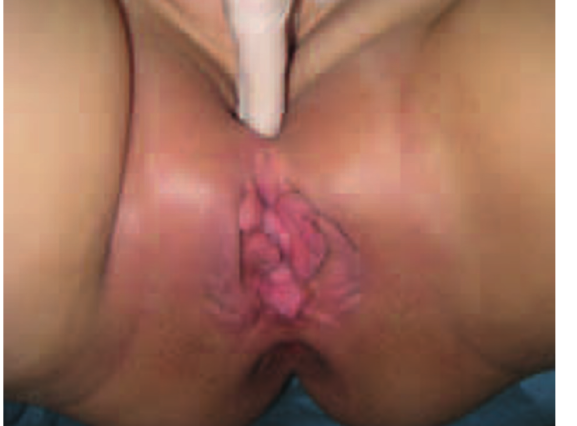
Figure 1. Before surgery